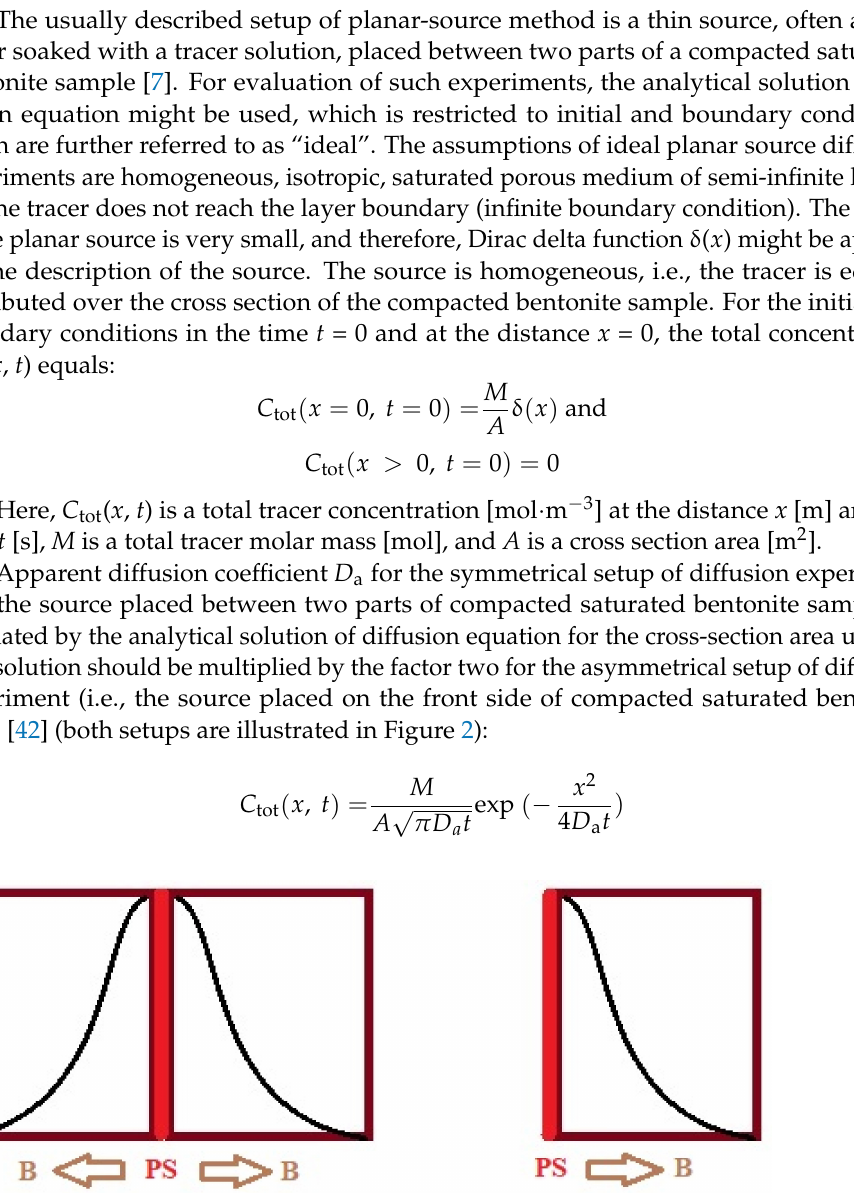
Figure 2. Schematic representation of symmetrical setup ( left ) and asymmetrical setup ( right ) of planar source diffusion experiment. PS—planar source,